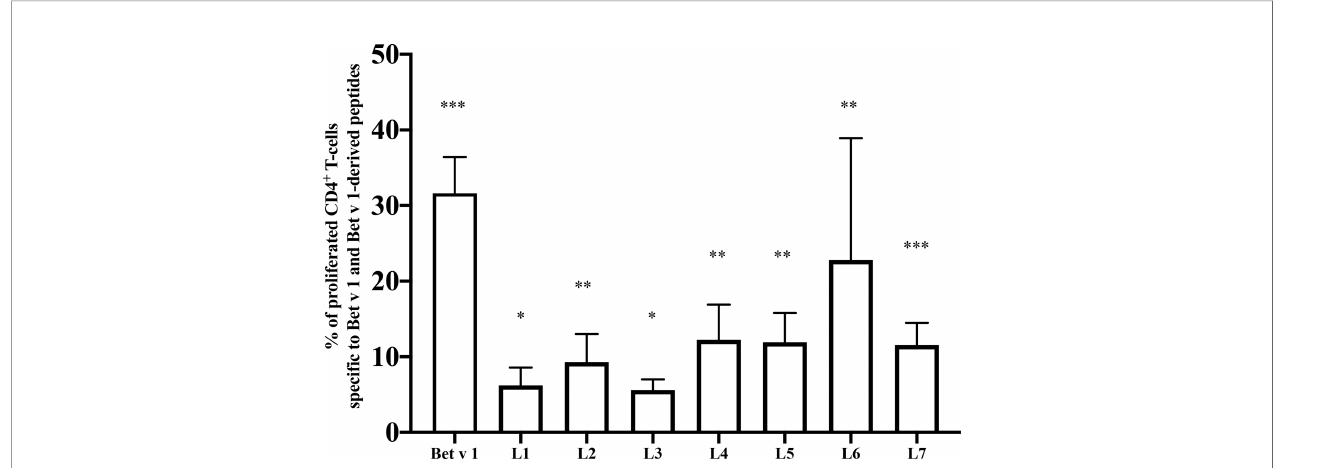
FIGURE 4 | Mapping of T cell epitopes in Bet v 1 sensitized BALB/c mice. Shown are the percentages of proliferated CD4 + T cells (y-axis) after subtraction of the medium control speci fi c for Bet v 1 and Bet v 1-derived long peptides (L1-L7) (x-axis). BALB/c mice (n = 7) were sensitized twice subcutaneously with 10µg of Bet v 1 as described in methods. After sacri fi ce, pooled splenocytes were labelled with CFSE and cultured with 5µg of Bet v 1 and 2.5µg of each of the Bet v 1-derived peptides. T cell proliferation responses were analyzed by fl ow cytometry 5 days after culture and by gating on live CD3 + CD4 + T cells. Proliferated lymphocytes were assessed by loss of CFSE fl uorescence intensity. Bars indicate means of triplicate cultures and standard deviations (SDs). Data were analyzed by a general linear model with a log link, comparisons of Bet v 1 and peptides against medium were done by Dunnett ’ s tests. Statistically signi fi cant differences between medium and Bet v 1, peptides and peptide mix are indicated (***P < 0.001, **P < 0.01, *P <